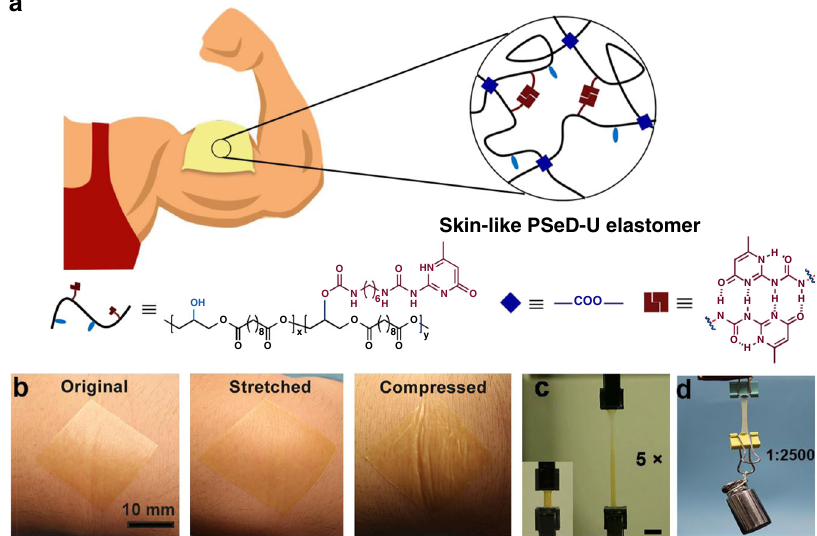
Fig. 1 Schematic and performance of skin-like PSeD-U elastomers. a The schematic illustration of the skin-like PSeD-U elastomers with physical and covalent hybrid crosslinked structures. b Photographs of spin-coated ultrathin PSeD-U20 fi lm (70 µ m thick) attached onto human skin: original, stretched, and compressed, illustrated its high conformability. Scale bar = 10 mm. c Photographs of original and fi ve times stretched PSeD-U20-12h elastomer specimen showed the high stretchability of PSeD-U elastomers. Scale bar = 10 mm. d PSeD-U20-12h elastomer (40 mg) could hold a weight of 100 g (2500× its own weight) revealing its high strength and